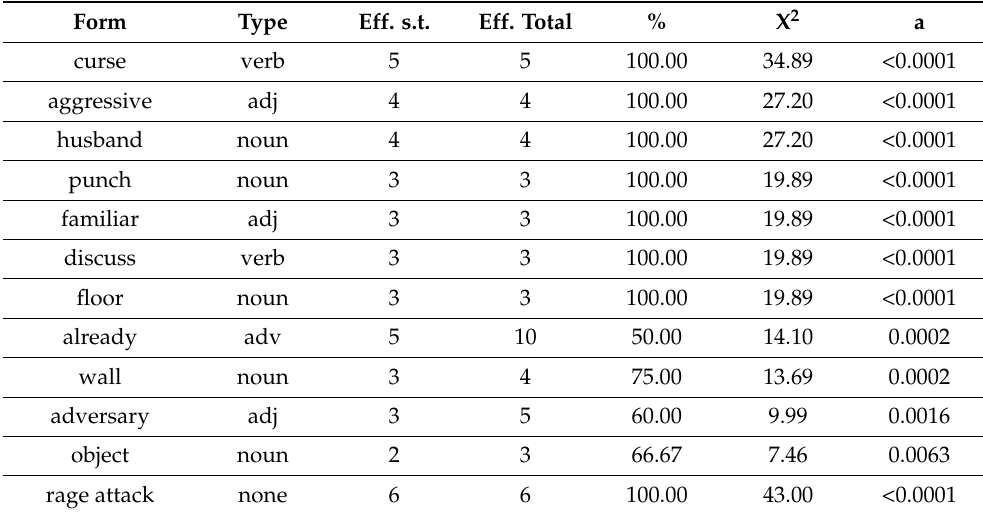
Table 2. More frequent words in class 3: Rage